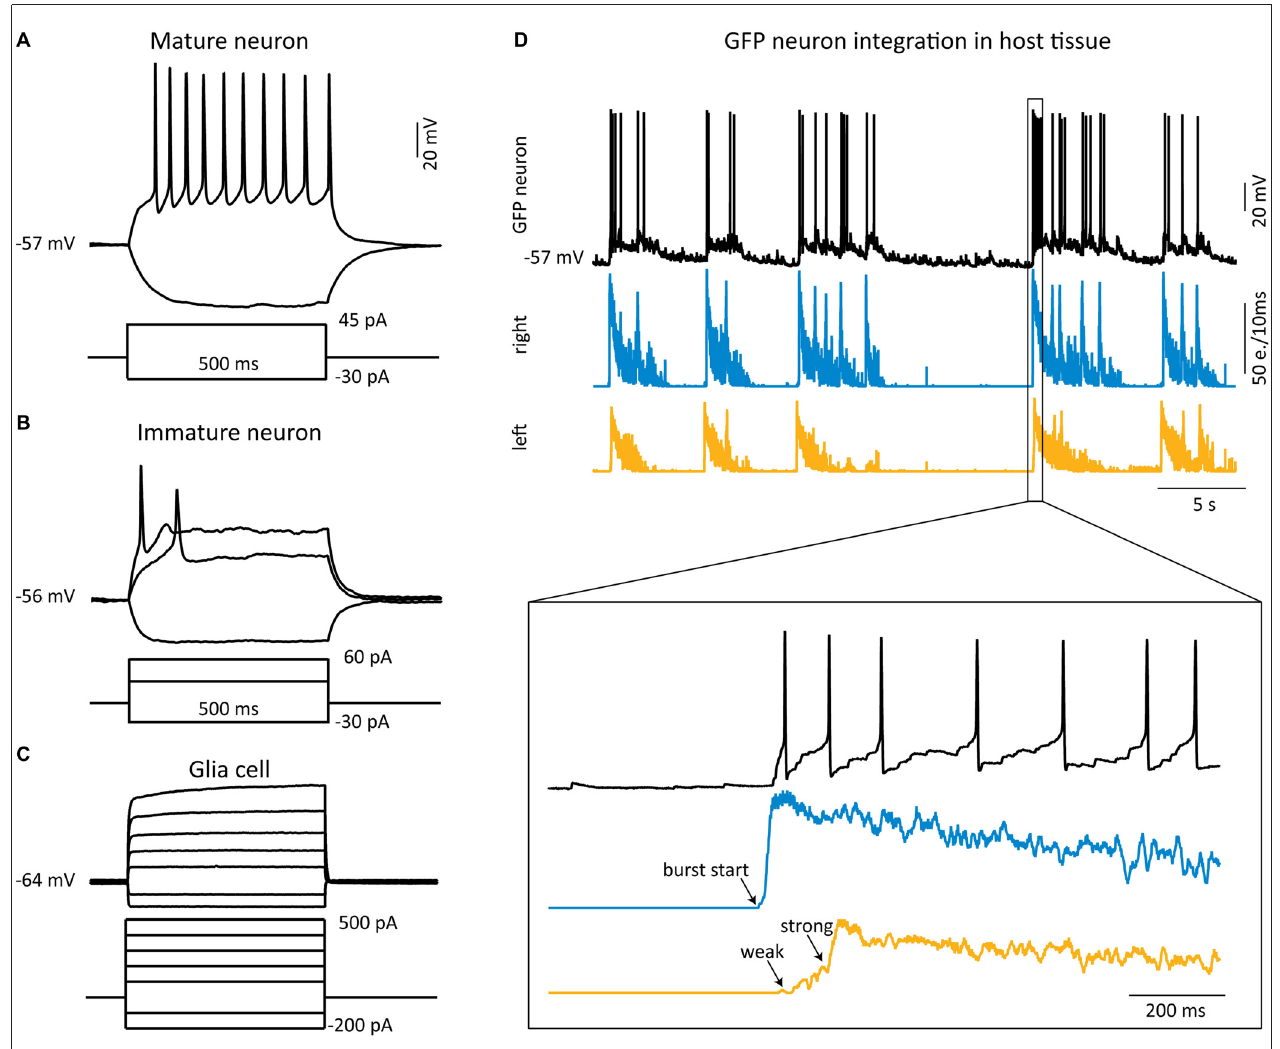
FIGURE 4 | Functional integration of grafted matured neurons into the host tissue. (A–C) Whole-cell current-clamp recordings (black traces) from single GFP cells from different sources 2–3 weeks after transplantation. (A) Example of sustained action potential firing induced by a depolarizing current step in a mature neuron (dissociated cell from SC). (B,C) Typical electrophysiological behavior of an immature neuron (B) and a glial cell (C) , both from FB NS. (D) Example of a simultaneous whole-cell recording (upper black trace) from a grafted Diss SC neuron with MEA recordings from the host tissue slices. The burst firing starts in the right slice (middle trace) and propagates to the left slice (lower trace), which displays first some weak, then strong bursting activity. The GFP neuron receives strong synaptic inputs from the right, leading slice resulting in action potential firing. e. =